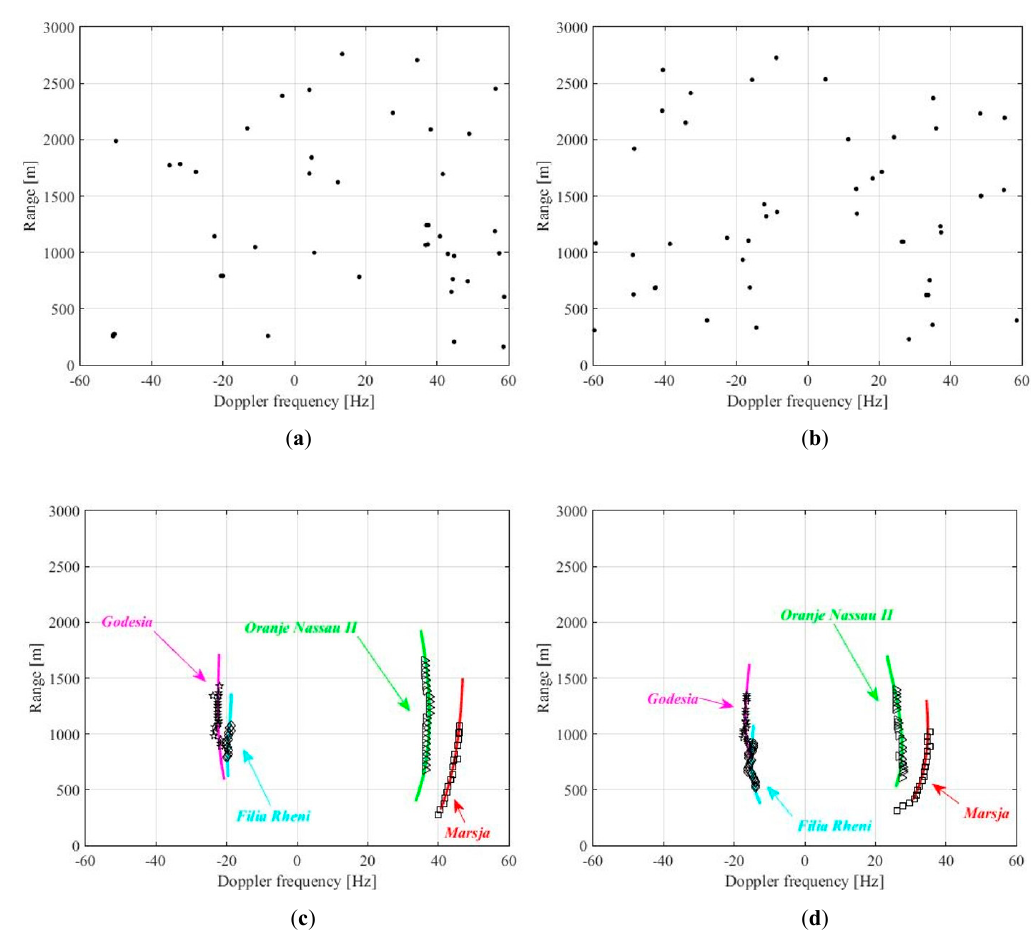
Figure 11. Rhine River detection results: ( a ) satellite 1 detection map for an individual scan; ( b ) Satellite